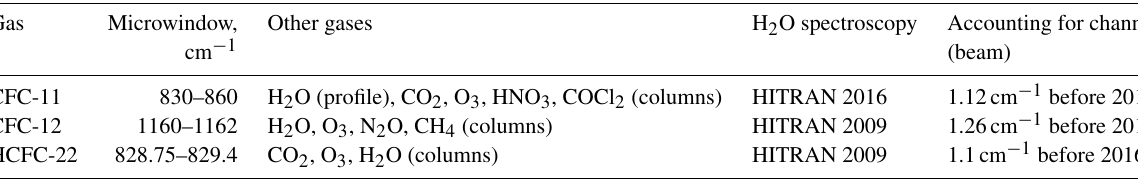
Table 1. The main parameters of the inversion of the spectra for deriving the TCs of halocarbons obtained by Polyakov et al. (2019a, b, 2020b).